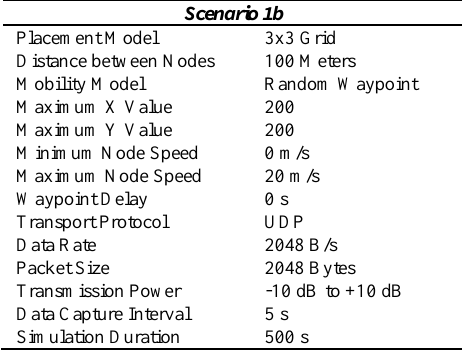
Table 8. Setting under Scenario 1b